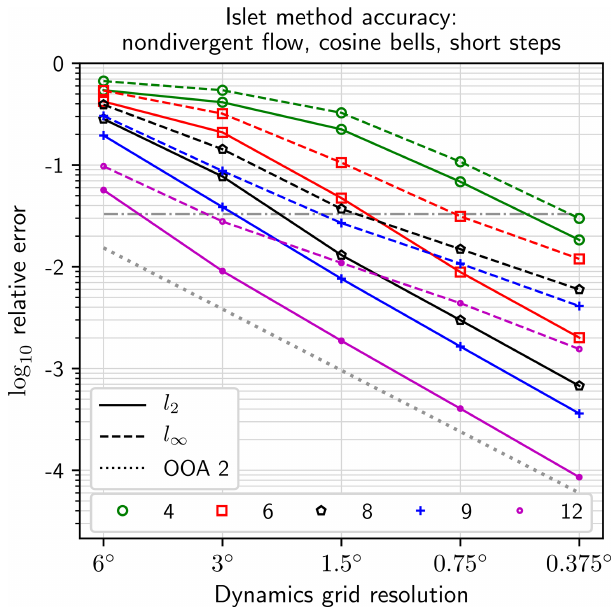
Figure 7. Accuracy diagnostic. Compare with Fig. 3 in TR14.